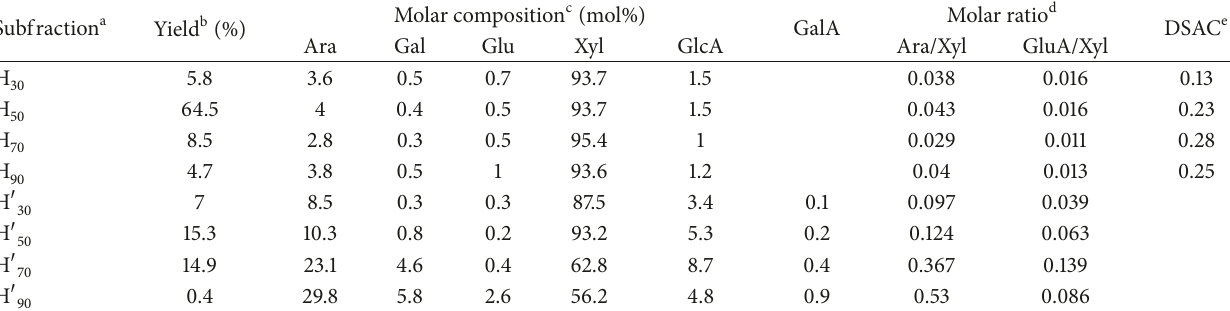
Table 2: The contents of neutral sugars and uronic acid (relative%, w/w) of hemicellulosic fractions obtained from DMSO-extracted and NaOH-extracted hemicelluloses.